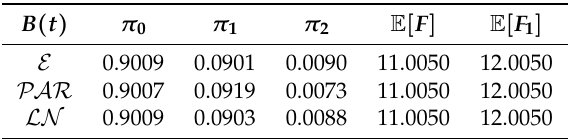
, M 1 ) versus B ( t ) 1